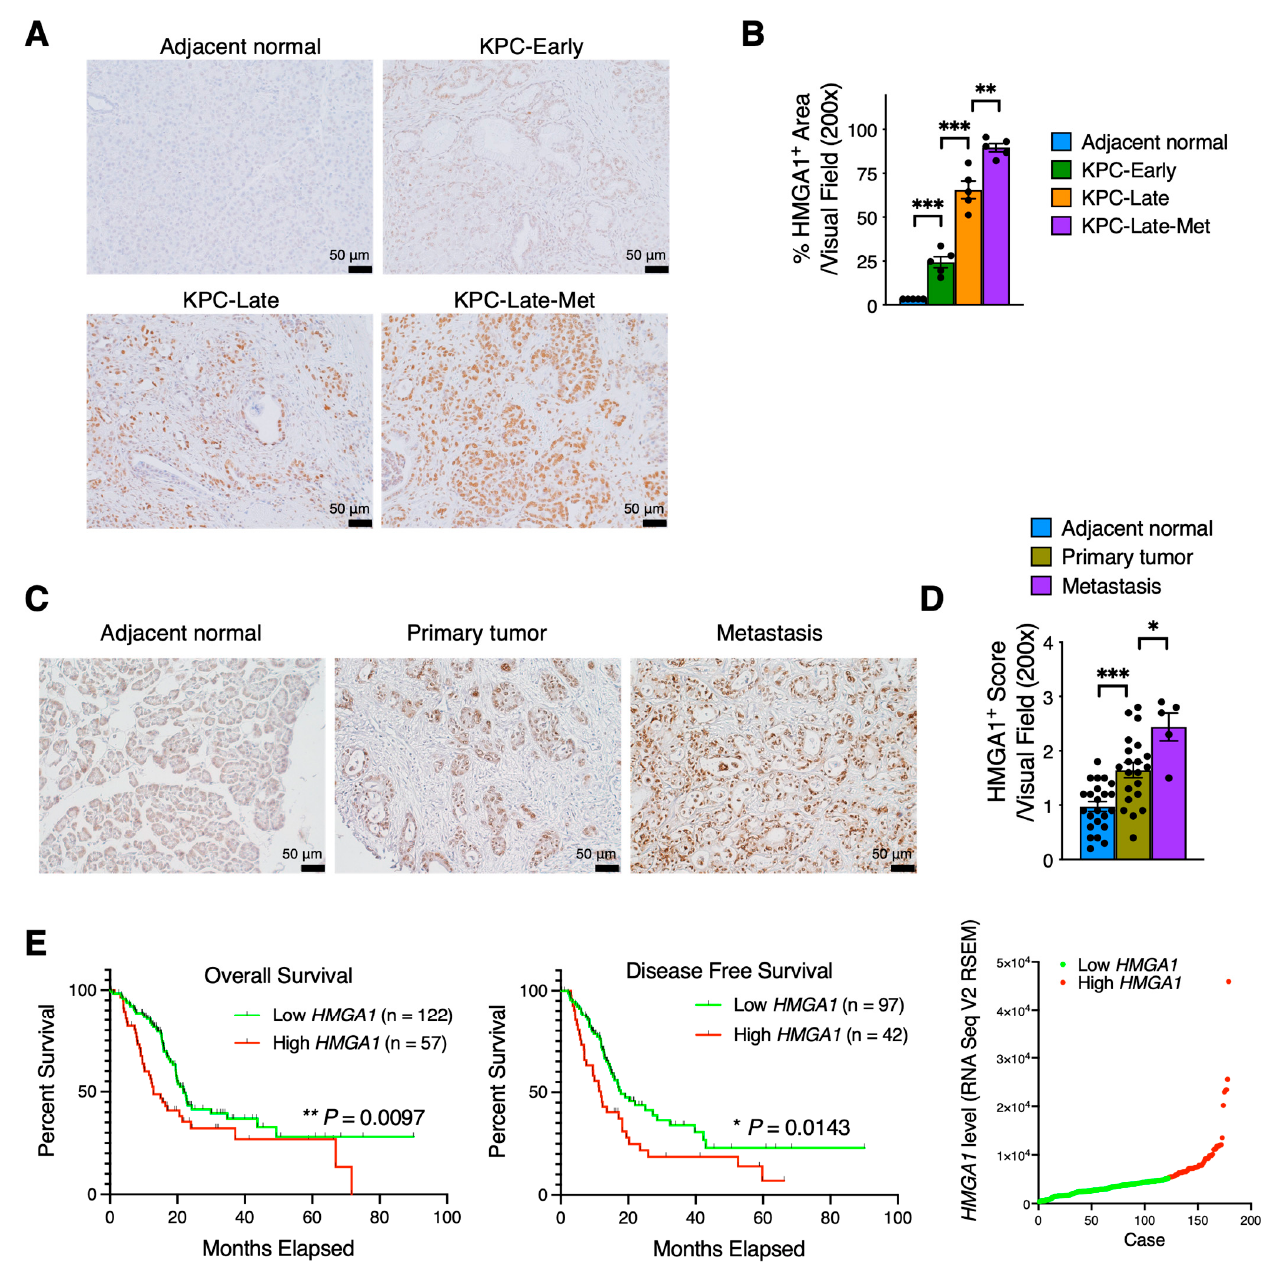
Figure 4. The expression level of HMGA1 is upregulated in cancer cells of liver metastases. ( A , B ) HMGA1 immunohistochemistry staining on tumor tissue sections from KPC mice at various stages of PDAC progression ( n = 5 mice per group). The representative images ( A ) and quantitative results ( B ) of HMGA1 staining are shown. **, p < 0.01; ***, p < 0.001. ( C , D ) HMGA1 immunohistochemistry staining on tumor tissue arrays from human PDAC patients. The representative images ( C ) and quantitative results ( D ) of HMGA1 staining are shown. *, p < 0.05; ***, p < 0.001. ( E ) Survival of pancreatic adenocarcinoma patients from TCGA dataset correlated with HMGA1 expression level. Log-rank (Mantel–Cox) test was used. Patients with available survival data and RNA-seq data ( n = 179) were stratified into two groups based on the average HMGA1 expression level as the cut-off value. Scatterplot illustrating the distribution of HMGA1 gene expression levels among PDAC patients is also shown. *, p < 0.05; **, p < 0.01.